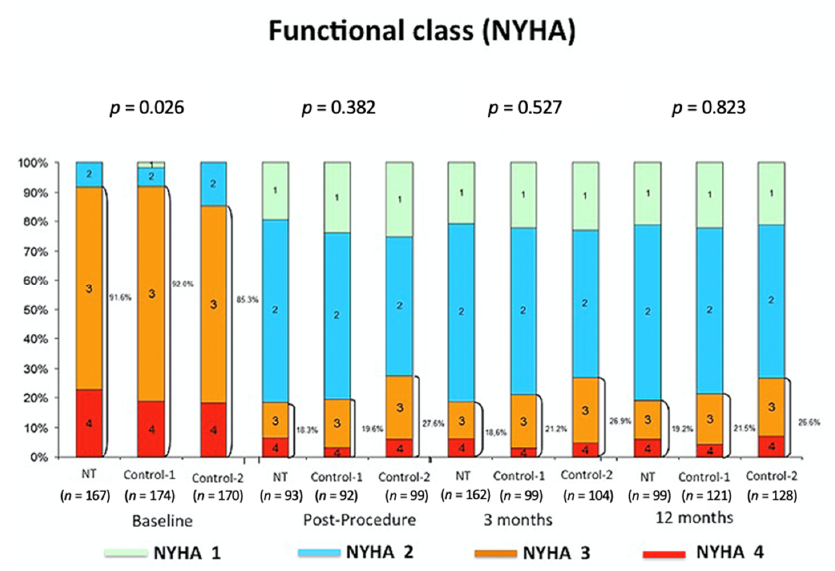
Figure 2. Functional class New York Heart Association (NYHA) at follow-up.